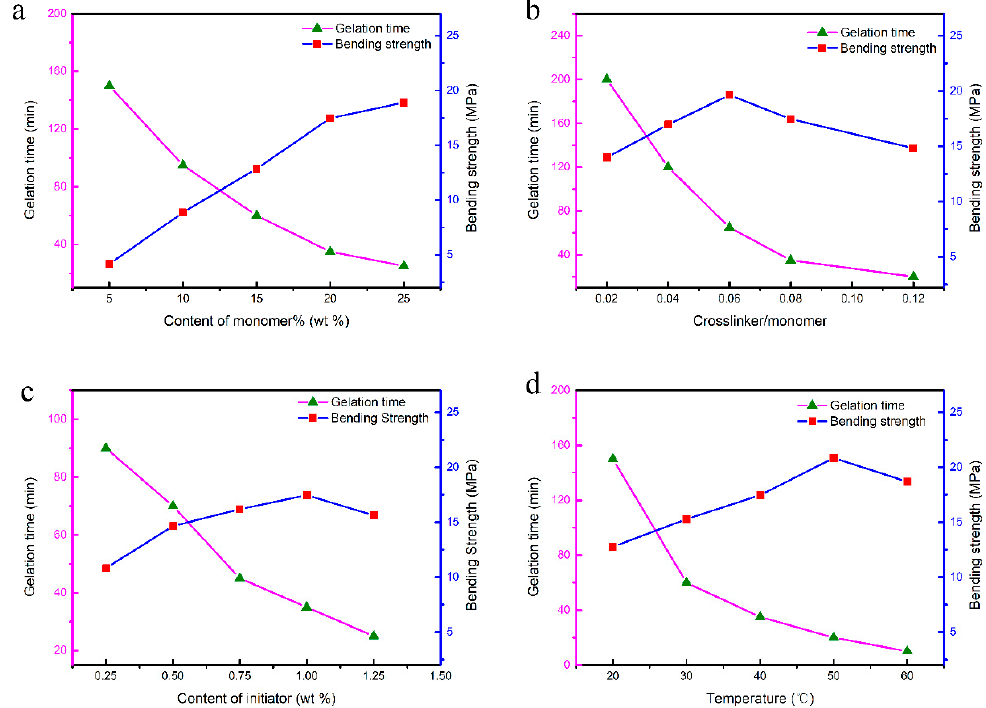
Figure 5. Effect of gelation parameters on gelation time and strength of green body: ( a ) content of monomer; ( b ) ratio of crosslinker to monomer; ( c ) content of initiator; ( d ) gelation temperature.